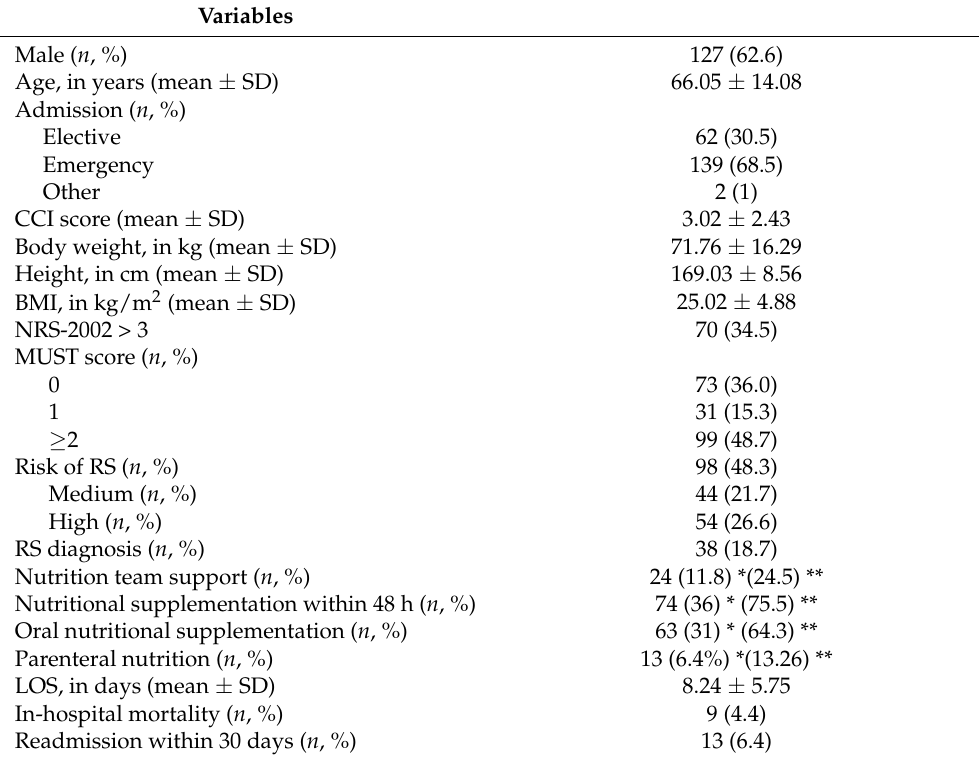
Table 1. Patients’ Characteristics ( n =